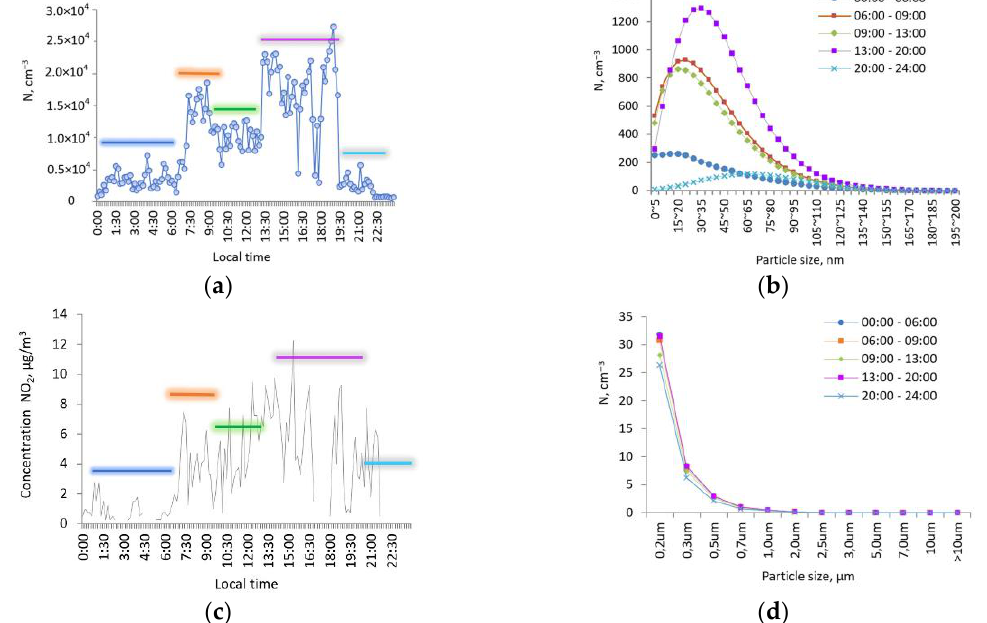
Figure 13. The daily course: the particle number concentration of the microdisperse fraction ( a ); particle distribution spectra ( b ); concentration of NO 2 ( c ); and particle distribution spectra of the submicron aerosol ( d ), 8 August 2020.